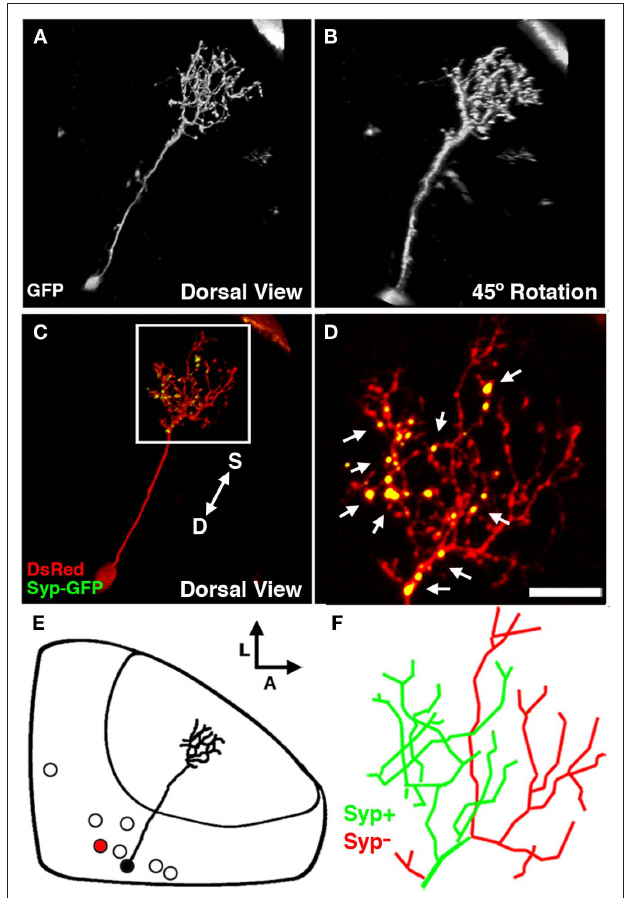
FiGure 7 | The non-stratified periventricular interneuron cell type. (A) Dorsal view of a two-photon image volume containing a single labeled nsPVIN imaged at 5 dpf. Note the long apical neurite extended into the neuropil. (B) Forty-five degree rotation of image volume in (A) . Note the absence of any stratification within the arbor. (C) Merged confocal image volume of a single 4 dpf nsPVIN expressing both dsRed (red) and Syp–GFP (green). Arrow depicts orientation of neuropil layers from superficial (S) to deep (D). (D) 2.5 × magnification of boxed region in (C) . Note the bright Syp–GFP puncta contained within a subset of neurite branches (arrows). (e) Schematic depiction of nsPVIN cell body distribution throughout the SPV layer. Cell traced in black corresponds to neuron in (A) and (B) . Note the deep SPV location of cell body. (F) Manual tracing of the neurite arbor in (D) . Green lines indicate branches containing Syp–GFP puncta, whereas branches devoid of Syp–GFP labeling are in red. Scale bar, 20 μm in (A–C) , 8 μm in (D,F)